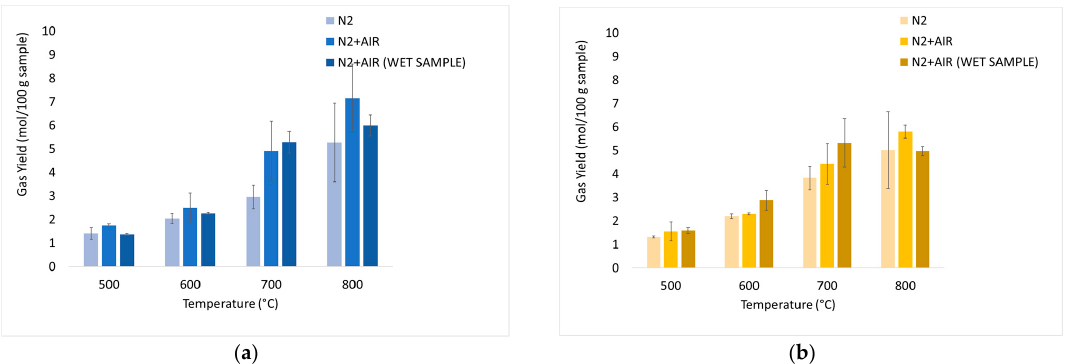
Figure 6. Experimental results of devolatilization tests as a function of temperature: integral-average gas yield ( η av , Equation (4)) of chirurgical ( a ) and FFP2 ( b ) masks.